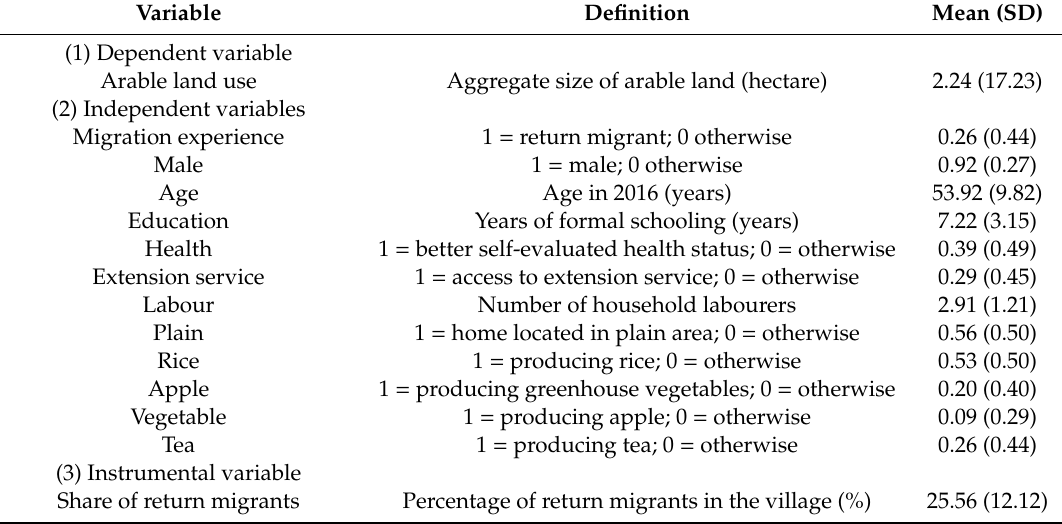
Table 2. Definition and descriptive summary of key